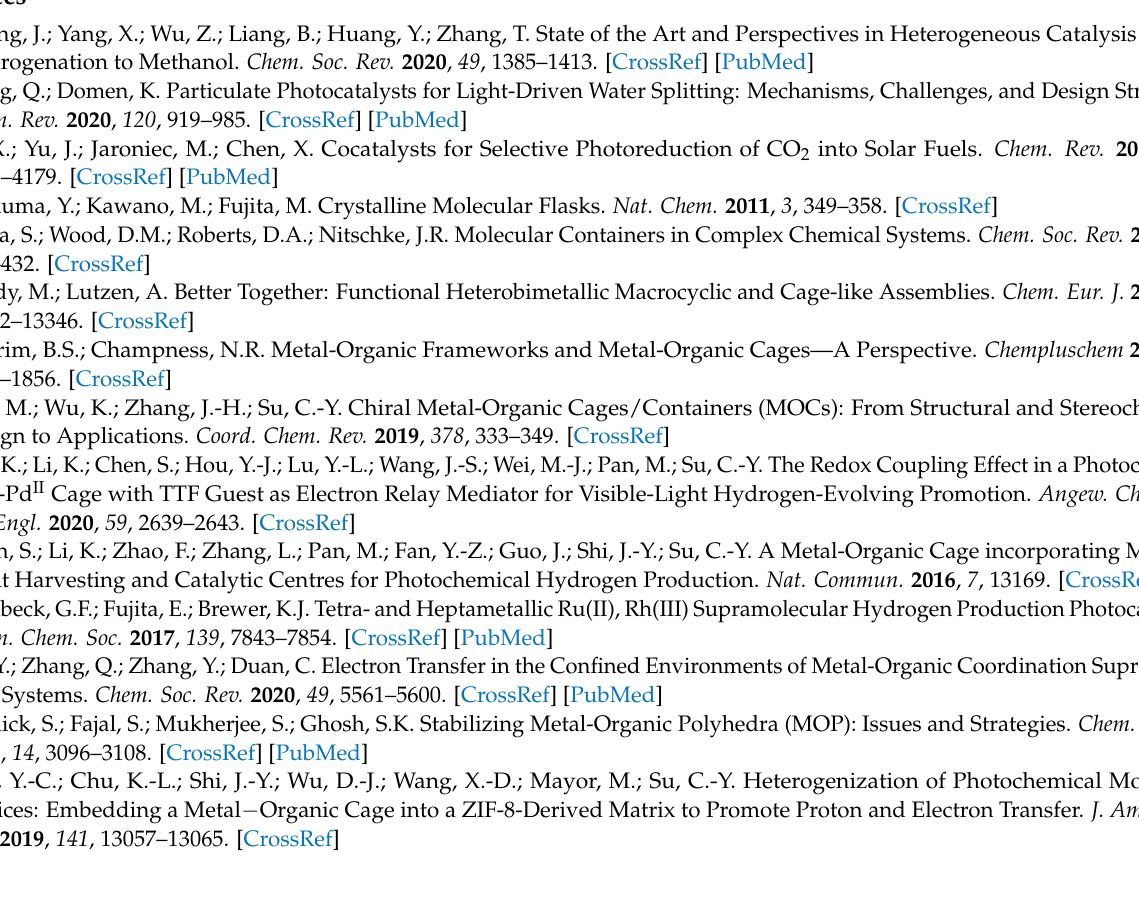
Figure S3: CV curves of (a) MOC-Q2 (0.1 mM) and (b) ferrocene, and (c) normalized absorption and emission spectra of MOC-Q2; Figure S4: The XPS Pd 3d spectra of g-C 3 N 4 /MOC-Q2 (2 wt%) (a) before and (b) after 10 h photocatalysis, and (c) the XRD patterns of g-C 3 N 4 /MOC-Q2 (2 wt%) samples before and after photocatalytic reaction; Figure S5: High-resolution TEM images of the spent g-C 3 N 4 /MOC-Q2 (2 wt%) sample after photocatalytic reaction; Figure S6: (a) Steady state and (b) time-resolved PL spectra of MOC-Q2, g-C 3 N 4 , and g-C 3 N 4 /MOC-Q2 (0.7